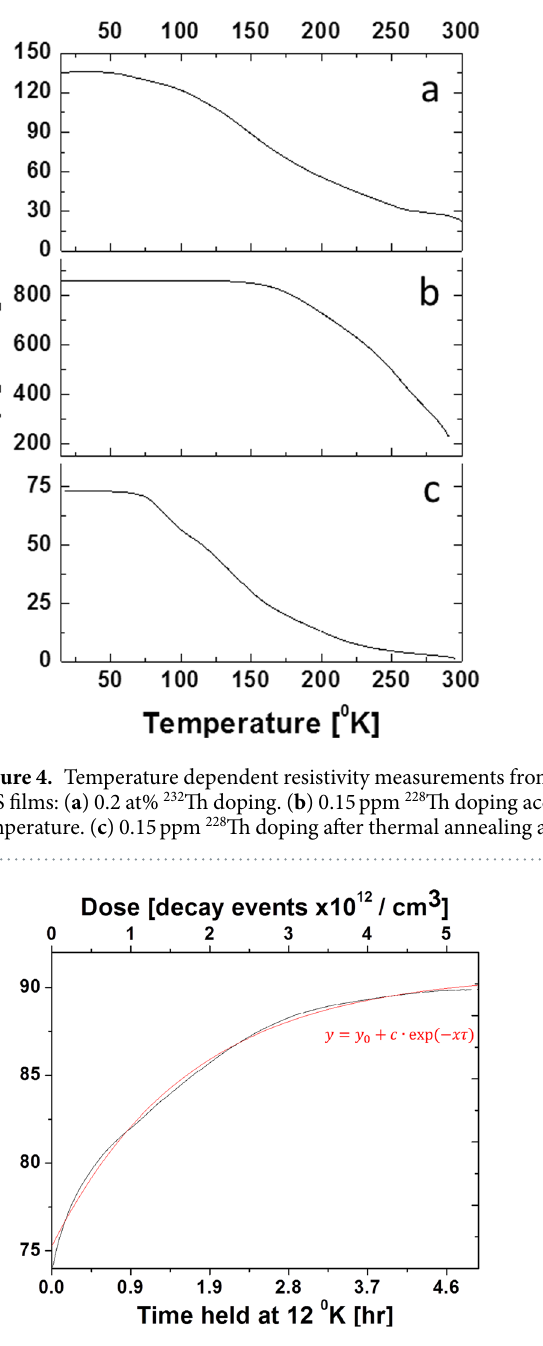
Figure 5. Damage accumulation in a PbS film doped with 0.15 ppm 228 Th after thermal annealing at 548 °K for 3 hr. Decay events were calculated for the entire decay